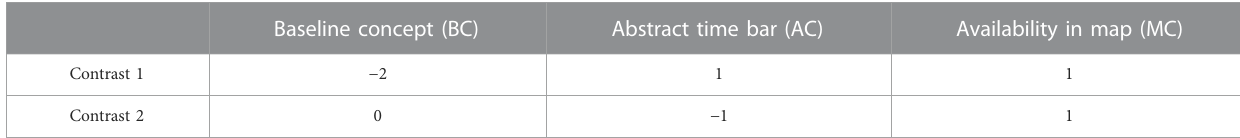
TABLE 1 Orthogonal contrasts used for contrast analysis.